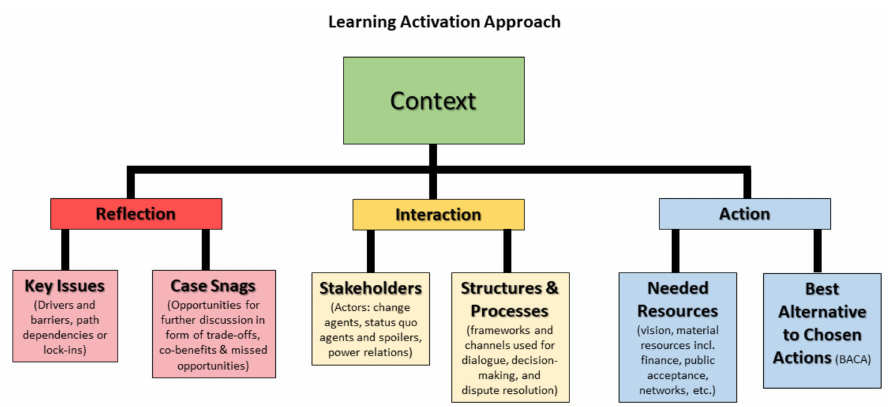
Figure 1. The Learning Activation Framework (own representation, CC BY